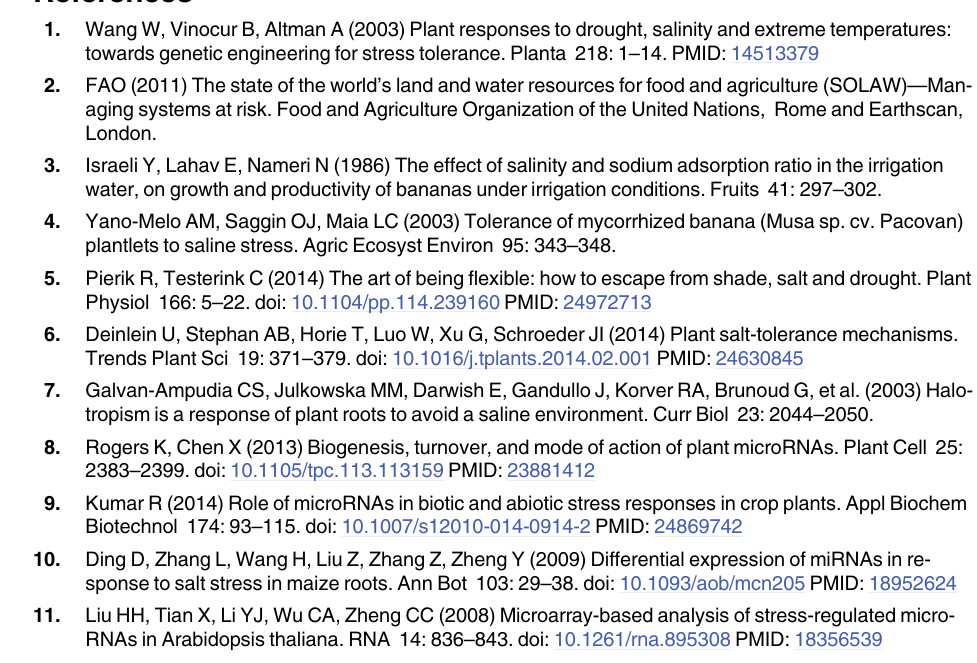
(Figure D). KEGG pathway assignment (Figure E). Length distribution of clean reads in small RNA libraries (Figure F). Classification of small RNA using PMRD and Rfam databases as refer- ence (Figure G). Gene Ontology (GO) assignment for targets of the differentially expressed miR- NAs in salt-stressed banana roots (Figure H). Dissociation curves of RT-qPCR for selected orthologous microRNAs (a-f) and Musa -specific microRNAs (g-l) (Figure I). Dissociation curves of RT-qPCR for selected target mRNAs (Figure J). Paired-end transcriptome sequencing (RNA-Seq) output (Table A). De novo assembly of banana root transcriptomes (Table B). Cover- age of the assembled transcriptomes (Table C). Mapping of the de novo assembled unigenes to the reference A-genome (Table D). Statistics of small RNA sequence reads (Table E). Annotation of orthologous miRNAs in banana root sRNAomes (Table F). Putative Musa -specific miRNAs in banana root sRNAomes (Table G). Functions of predicted salinity-responsive miRNA / mRNA targets in banana roots (Table H). Stem-loop (SL) primers used for reverse transcription (Table J). Primers used for real-time RT-qPCR analyses of target mRNAs (Table K).